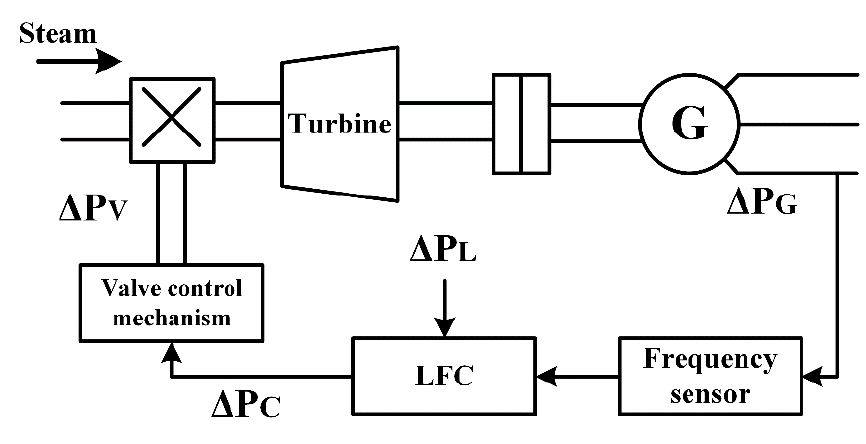
Figure 2. The schematic diagram of a typical steam turbine [30].